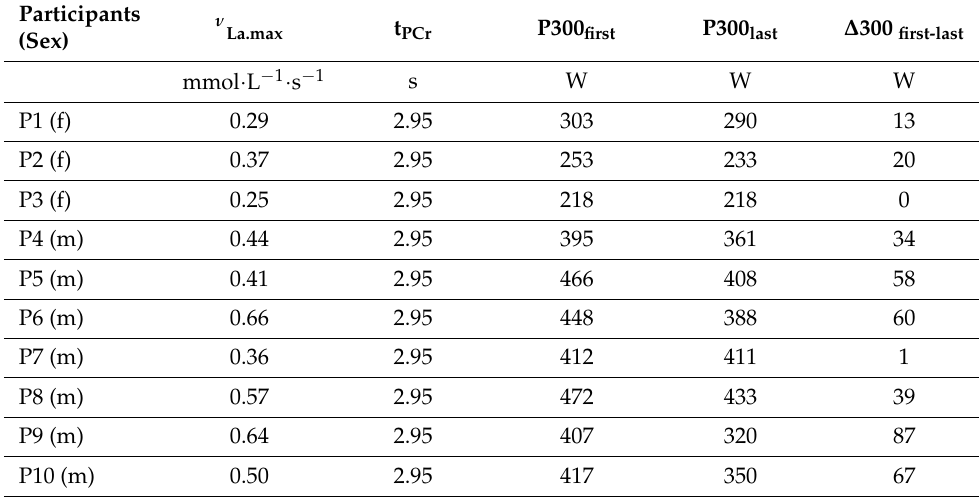
Table 3. Maximum rate of lactate accumulation ( ν La.max ) and power output (W) over certain sections during 2000 m